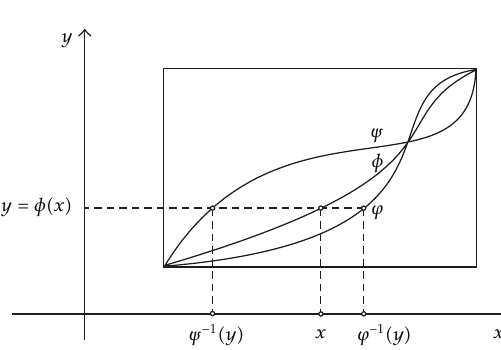
Figure 3: Convex combination of strictly monotone increasing functions ϕ and